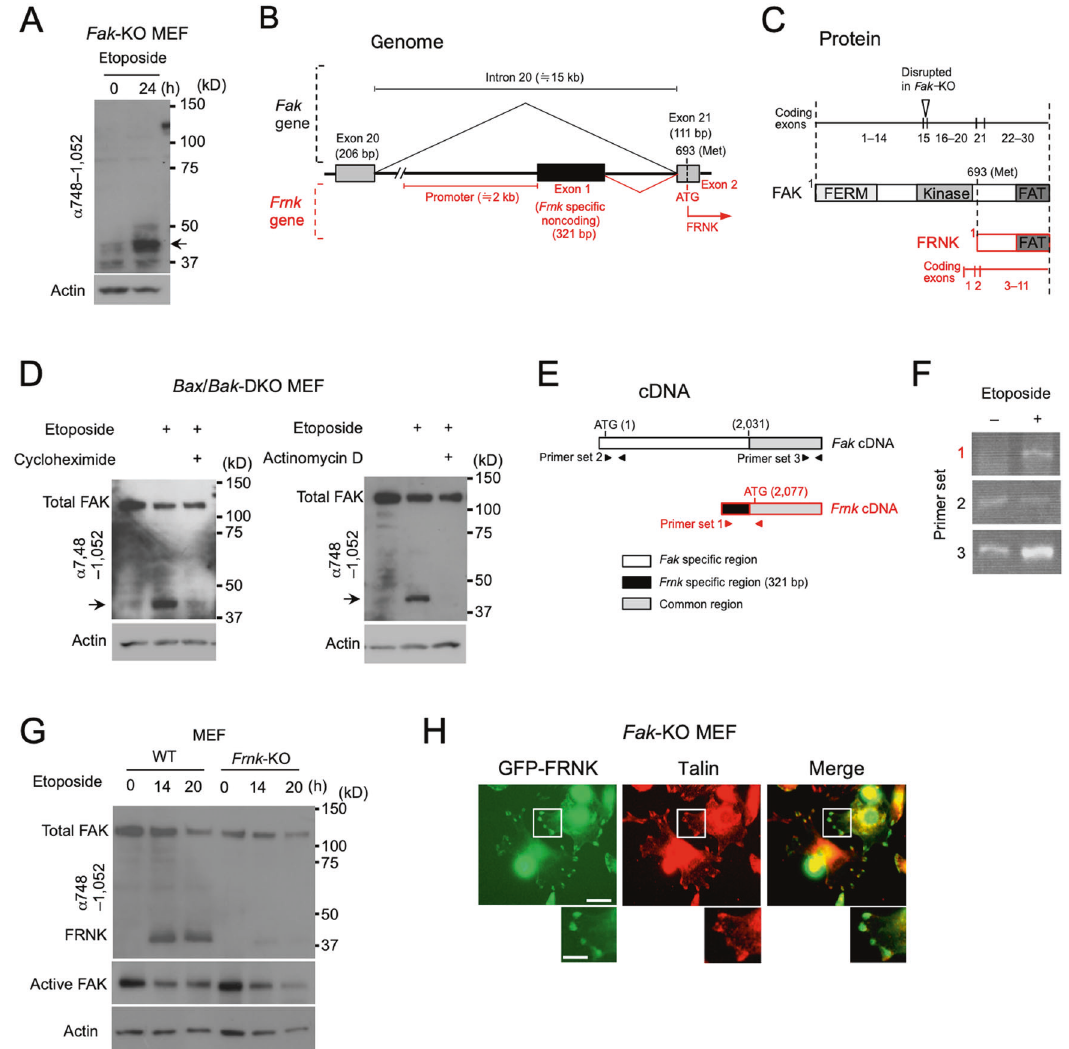
of the Fak gene (black), and the promoter region and exons 1 and 2 of the Frnk gene (red). The initiation codon for the translation of Frnk resides in exon 21, and intron 20 contains the promoter and the unique noncoding exon of the Frnk gene. Sizes of each exon are indicated in parentheses. C Schematic diagram comparing the protein structures of FAK (black) and FRNK (red), as well as demonstrating the positions of their corresponding exons. The 693rd methionine residue of FAK is the start site of FRNK translation, and exon 15 is disrupted in Fak -KO MEFs. D Immunoblot analysis showing transcription- and translation-dependent generation of the FAK-associated 40-kDa band in Bax / Bak -DKO MEFs (arrows). For the inhibition of translation and transcription, WT MEFs were treated with 20 µM etoposide for 14 h together with cycloheximide (5 µg/mL) or actinomycin D (0.2 µg/mL). E Schematic representation of Fak (black) and Frnk (red) cDNAs. Fak -speci fi c, Frnk -speci fi c, and common regions are shown in white, black, and grey, respectively. The ATG initiation codon of Fak and Frnk are indicated. Numbers in parentheses denote the nucleotide positions from the fi rst nucleotide of Fak translation. Arrowheads indicate the locations of the primer sets used to amplify each region. F RT-PCR using the primer sets indicated in ( E ), which shows the expression of FRNK mRNA but not FAK mRNA by etoposide treatment in Bax / Bak -DKO MEFs. G Immunoblot analysis showing the absence of the 40-kDa product in Frnk -KO MEFs treated with etoposide (20 µM). H Fluorescence images showing the localization of GFP-FRNK in focal adhesions. Fak -KO MEFs transiently expressing the GFP protein were counterstained with an anti- talin antibody. Magni fi ed images of the boxed regions are shown under each original image. Scale bars, 20 µm (original image) and 10 µm (magni fi ed image). For all immunoblot experiments in Fig. 2, actin was used as a loading